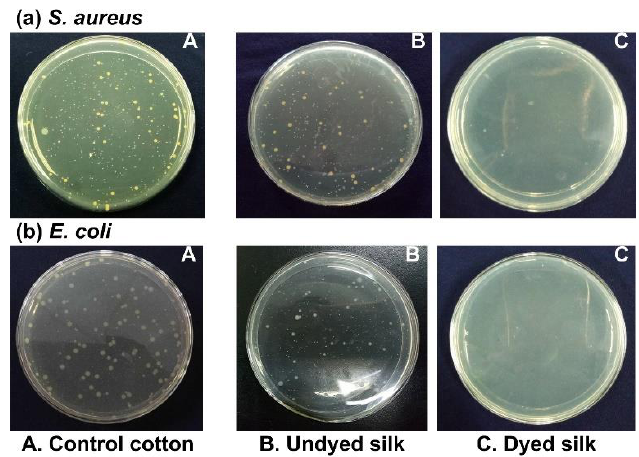
Figure 8. Visual bacterial cultures for the control cotton ( A ), the undyed silk ( B ), and the dyed silk with the 6 g/100 mL PGA/Glc reaction products ( C ).